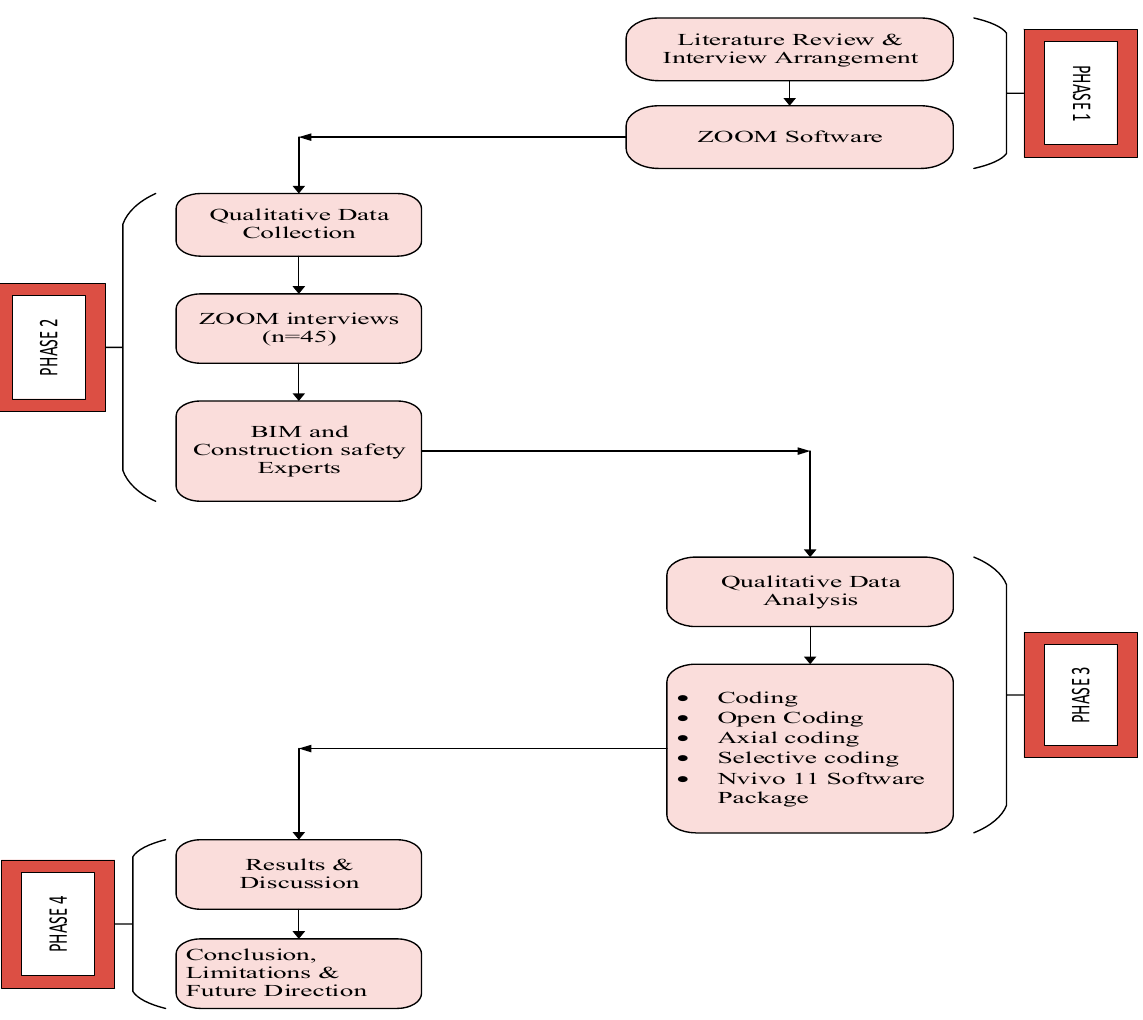
Figure 1. Research methodology flowchart.